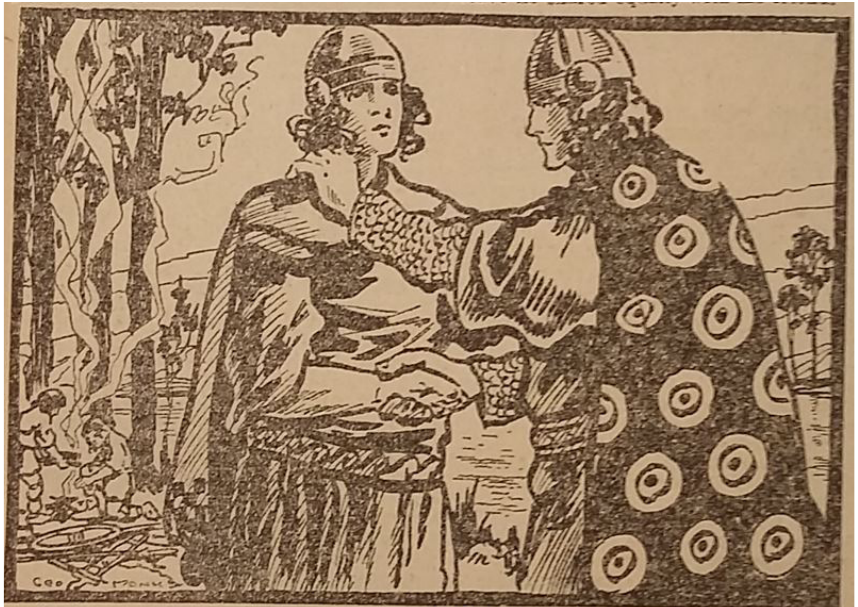
Fig. 4 Illustration from Our Boys depicting Cuchulainn and Ferdiad shaking hands. Image Courtesy of the National Library of